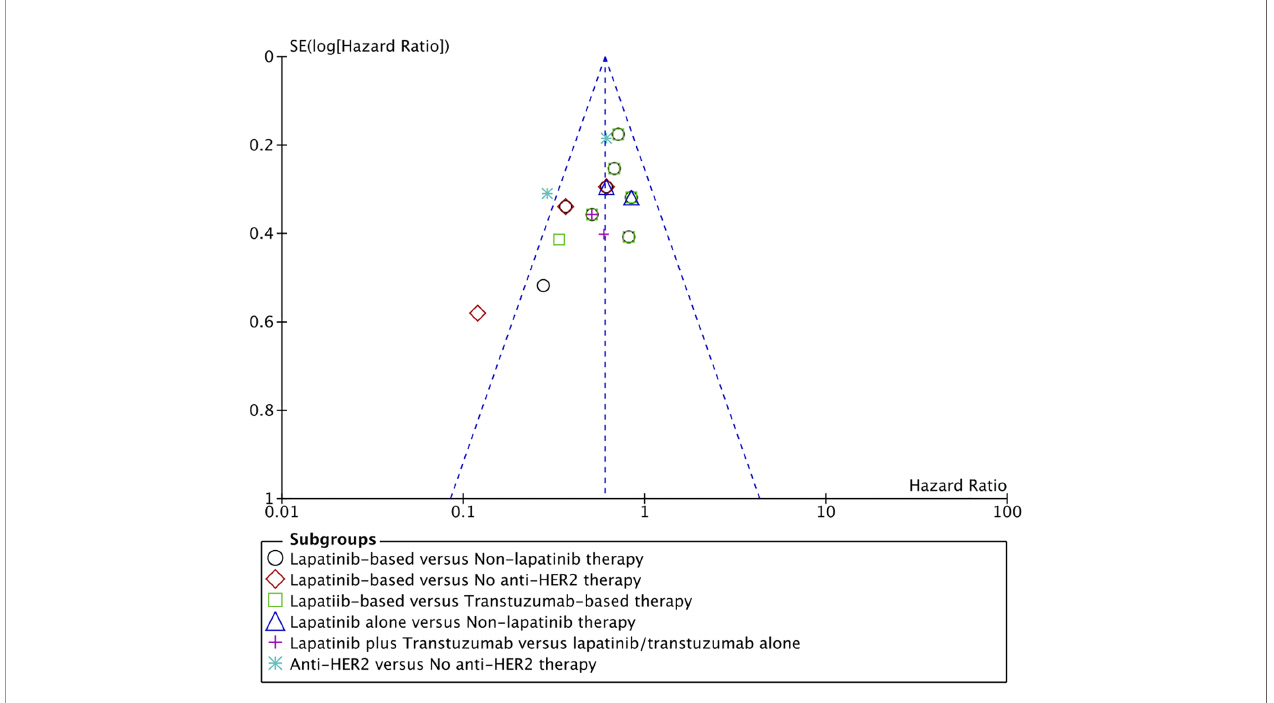
FIGURE 4 | Funnel plot of publication bias assessment for overall